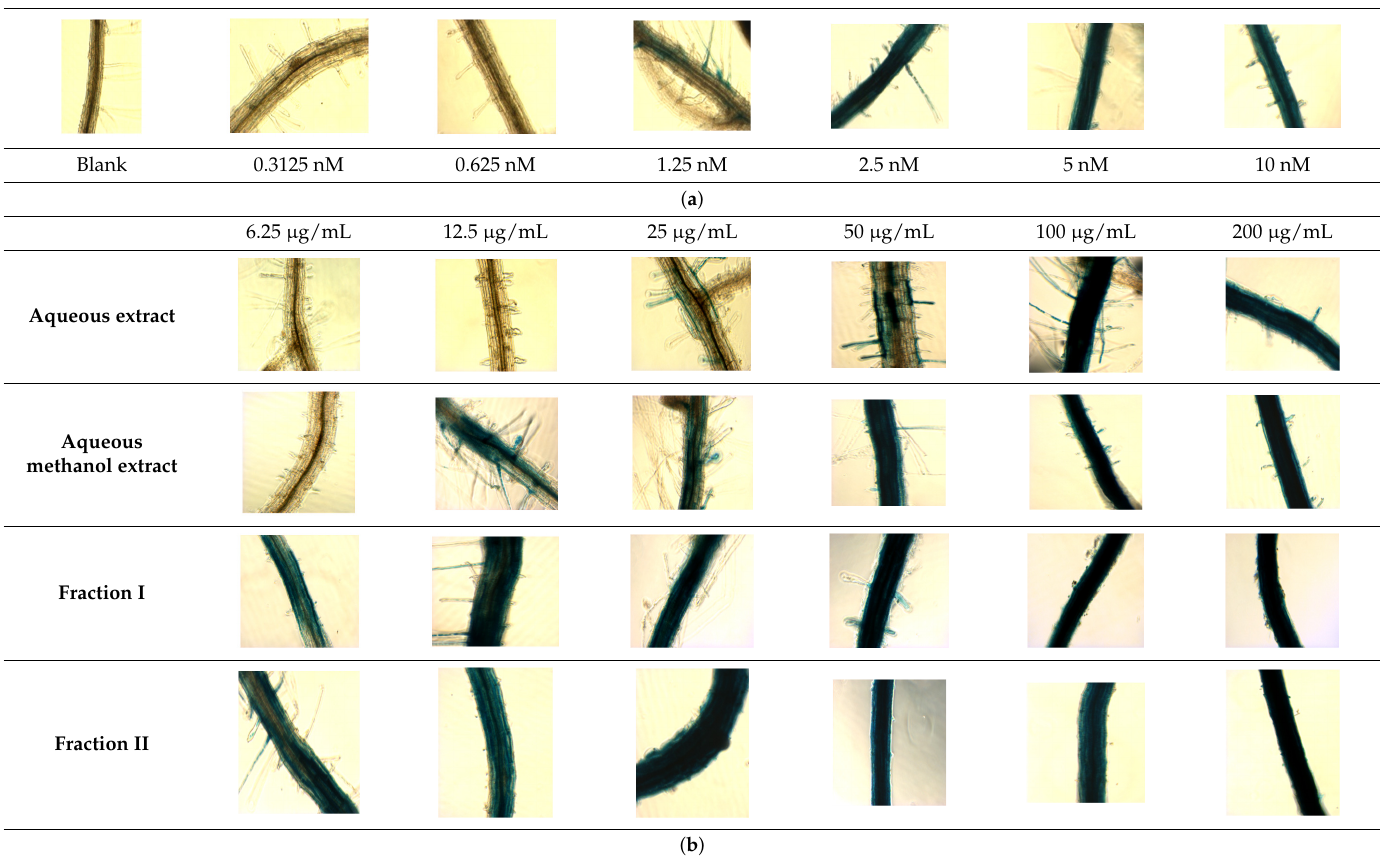
Figure 3. Phytoestrogenic effects of ( a ) 17 β -estradiol (E 2 ) and ( b ) Fractions I and II from Erythrina crista-galli in the Arabidopsis thaliana pER: GUS system. ( a ) Estrogenic activity of the reference compound 17 β -estradiol was evaluated utilizing the pER8: GUS reporter assay system. MAC of 17 β -estradiol was 2.5 nM; ( b ) Fractions I and II exhibited the most obvious estrogenic activity with the MAC values lower than 6.25 µg/mL. Aqueous and aqueous methanol extracts showed less activity with the MAC values of 25 and 12.5 µg/mL, respectively.